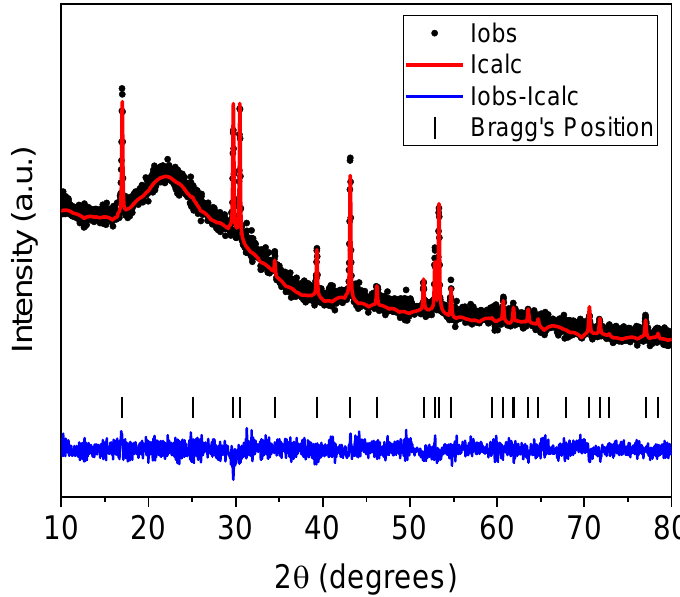
Figure 4. Rietveld-refined XRD spectrum of Er-GC (heat-treated at 650 °C for 40 h).